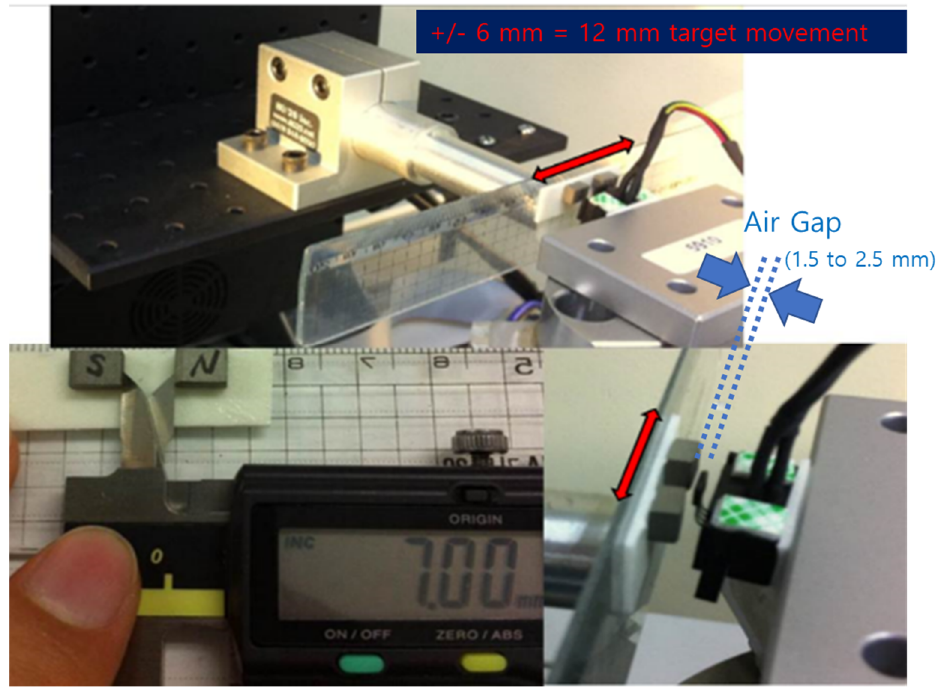
Figure 7. Test setup for 3D Hall sensors with 12 mm range of magnet position.